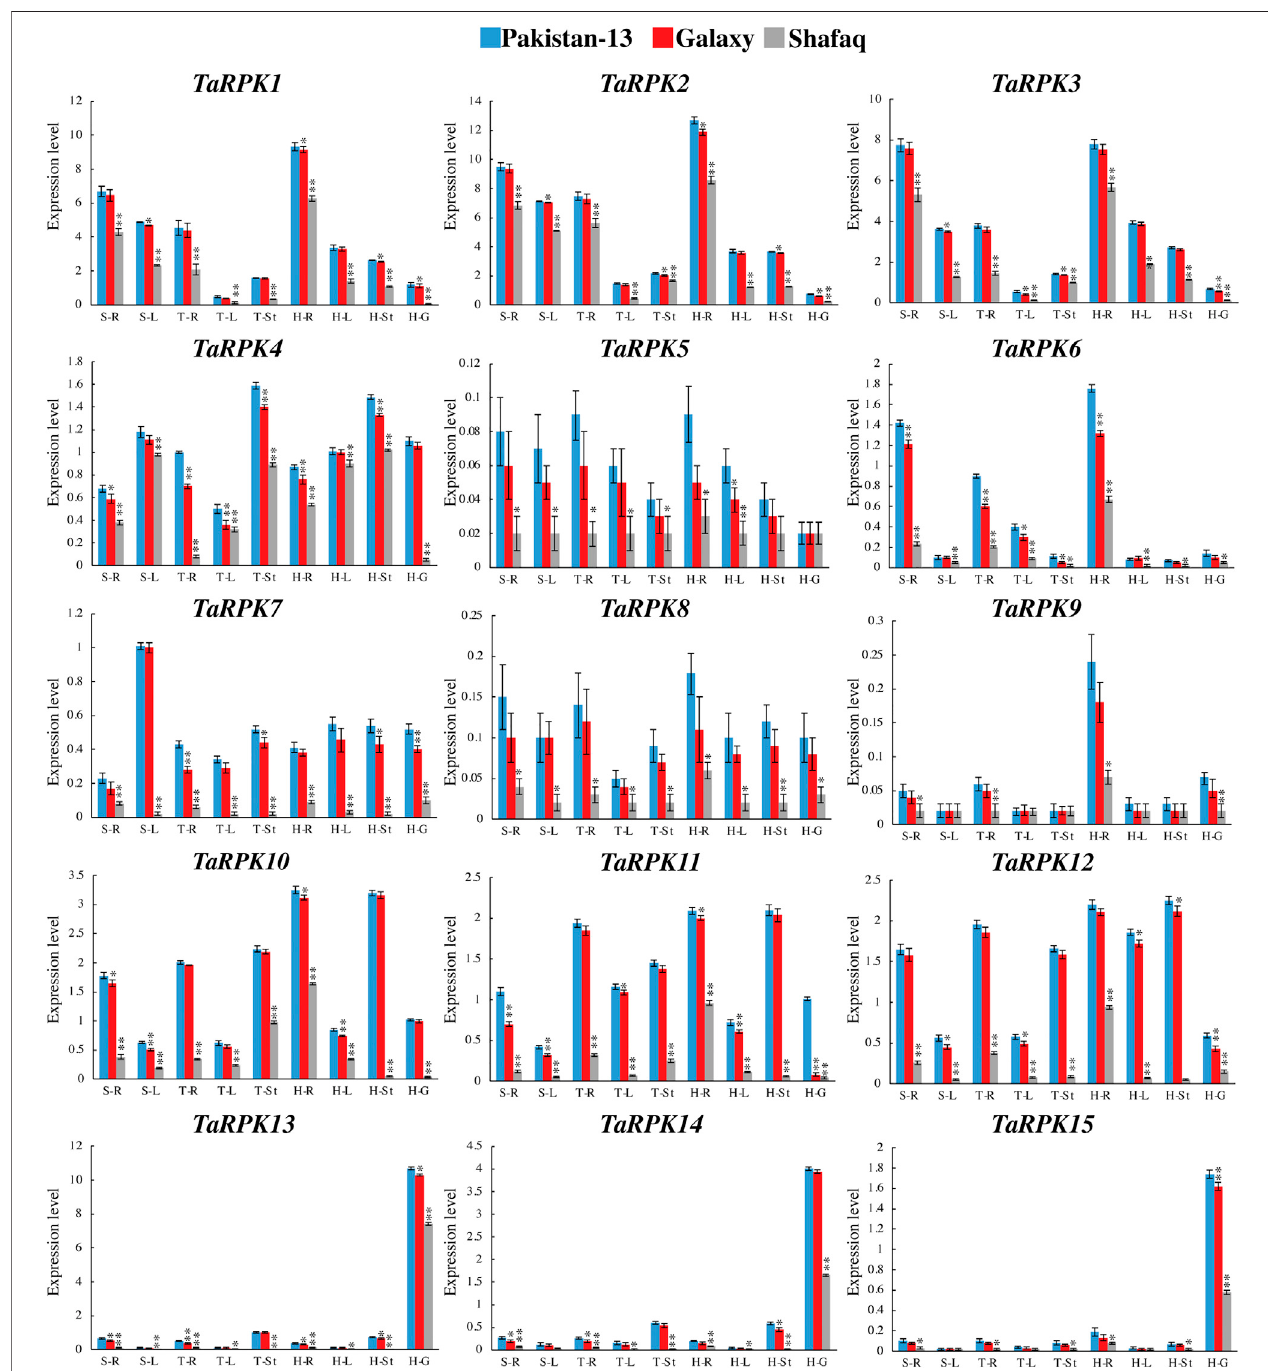
FIGURE 9 | Real time PCR-expression analysis of TaRPK1 genes in wheat varieties; Pakistan 13 (blue), Galaxy (red), and Shafaq (gray). The wheat plant was germinatedandgrowninsoilundernormalconditions.Expressionsof TaRPK1 genesweredeterminedinroot(R),stem(St),leave(L),andgrain(G)atseedling(S),tillering (T),and heading(H)stages. Standarddeviation(SD)ofthreebiologicalreplicatesisrepresentedbytheerrorbars.Signi fi cancewasassessed byusinga t -test(* p < 0.05, ** p < 0.01, and ns = non-signi fi cant).